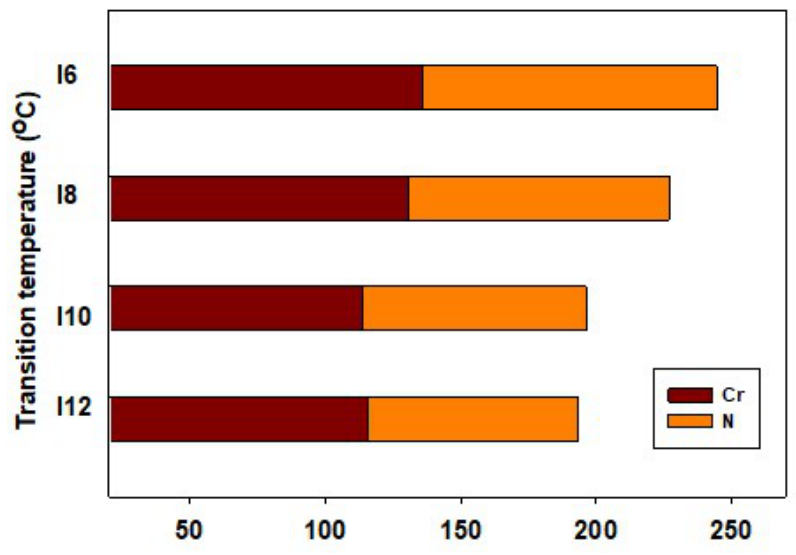
Figure 3. Graphical DSC transitions of the investigated derivatives, I n .